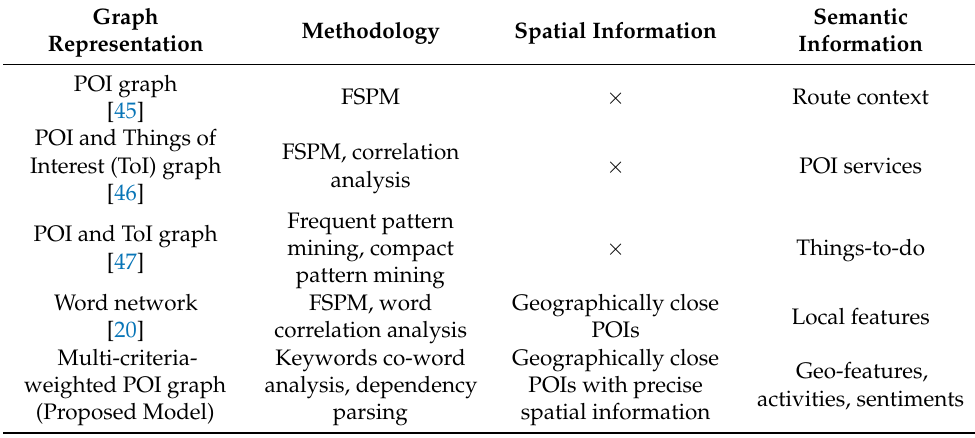
Figure 12. A POI graph of geographically close locations with local features [20]. Table 10. Comparison between the proposed and existing POI graph representations.